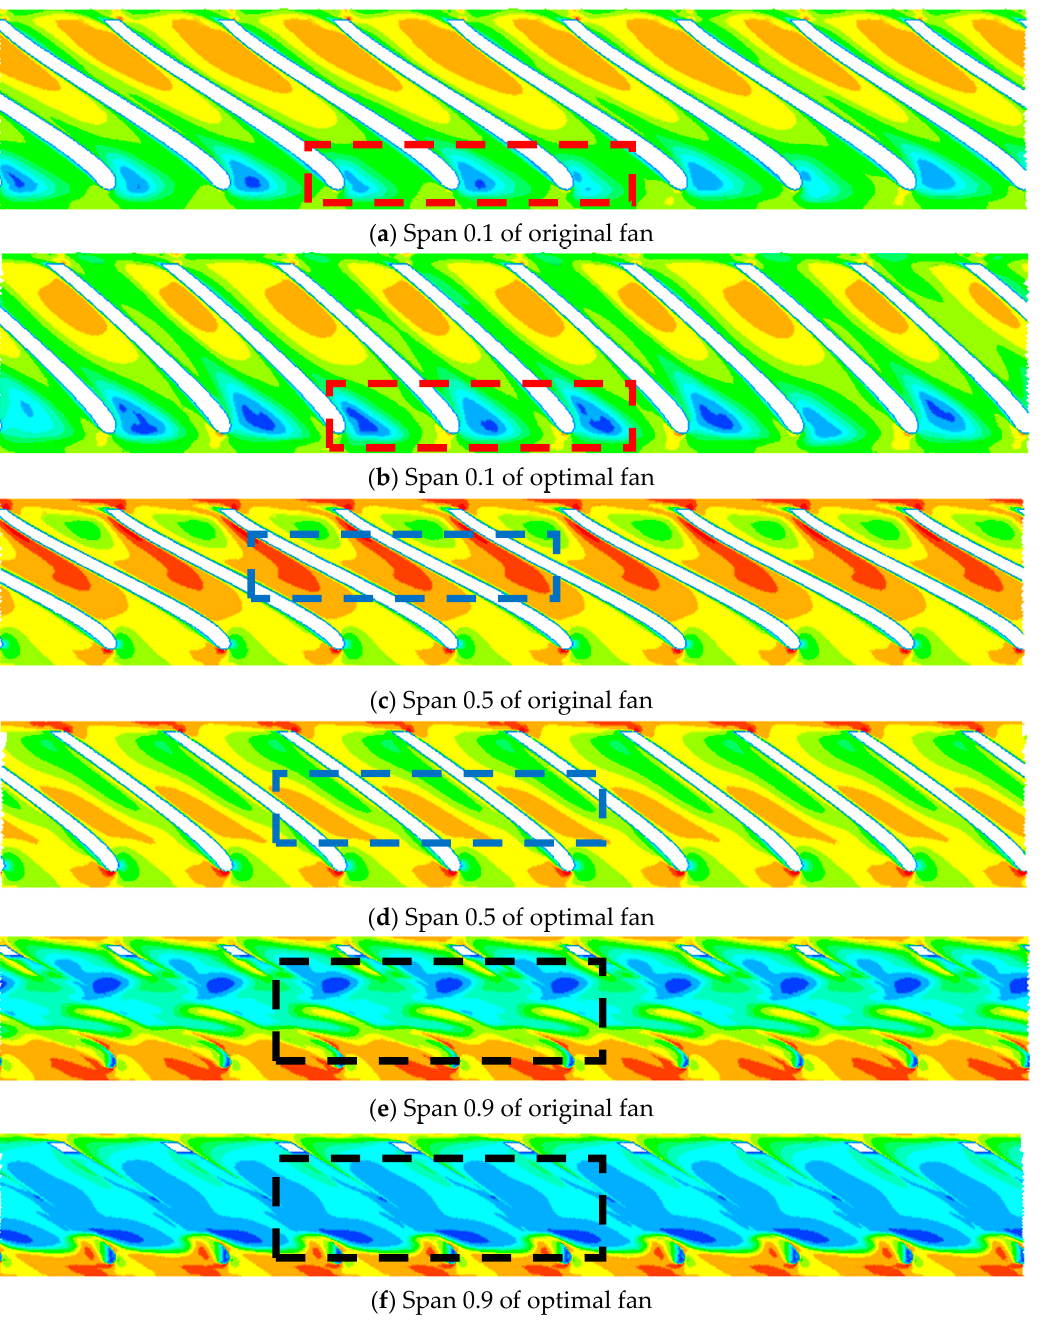
Figure 7. Velocity distribution of different spans. ( a ) Span 0.1 of original fan; ( b ) Span 0.1 of optimal fan; ( c ) Span 0.5 of original fan; ( d ) Span 0.5 of optimal fan; ( e ) Span 0.9 of original fan; ( f ) Span 0.9 of optimal fan.